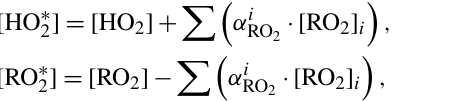
β -pinene oxidation